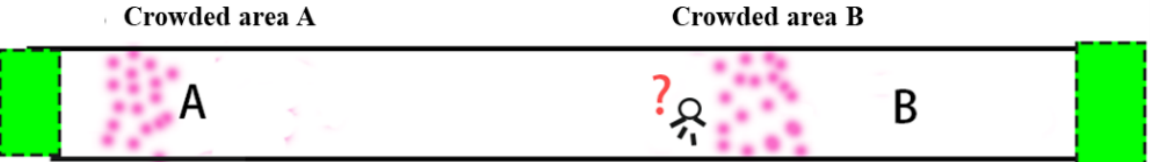
evacuation route.